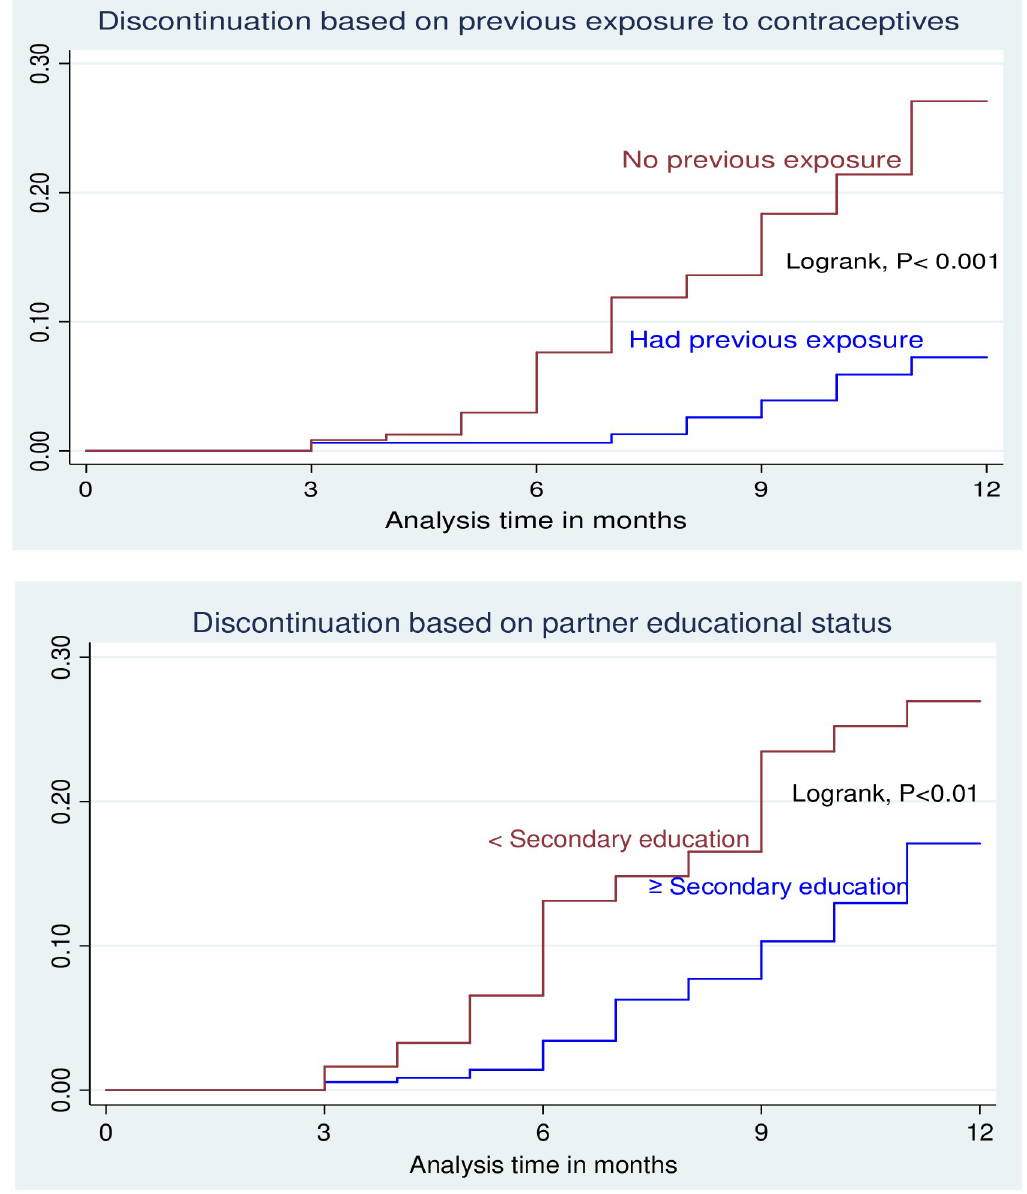
Fig 3. Incidence of unplanned discontinuation of Implanon based on previous exposure to contraceptives and partner educational status at Ayder comprehensive specialized hospital, Mekelle, Northern Ethiopia, 2016–2017 (n = 413).